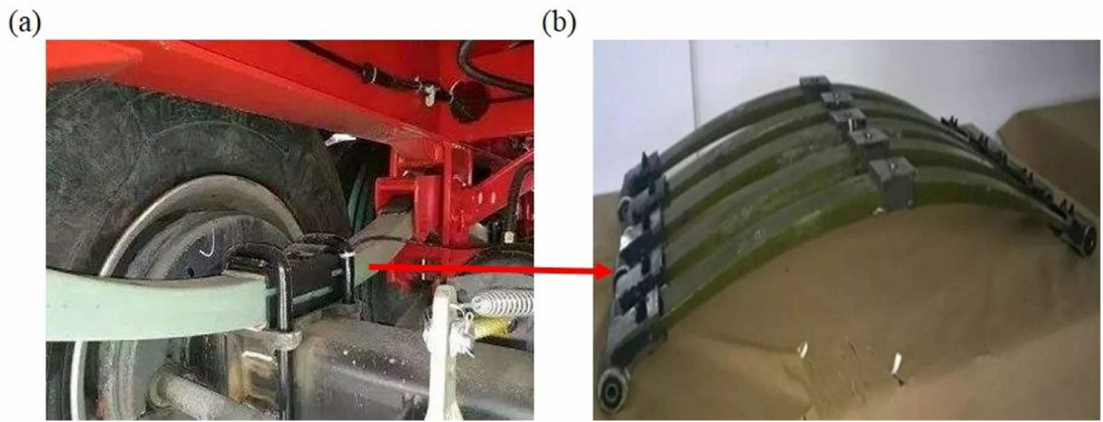
Figure 1. ( a ) Installation environment and ( b ) typical structure of composite leaf